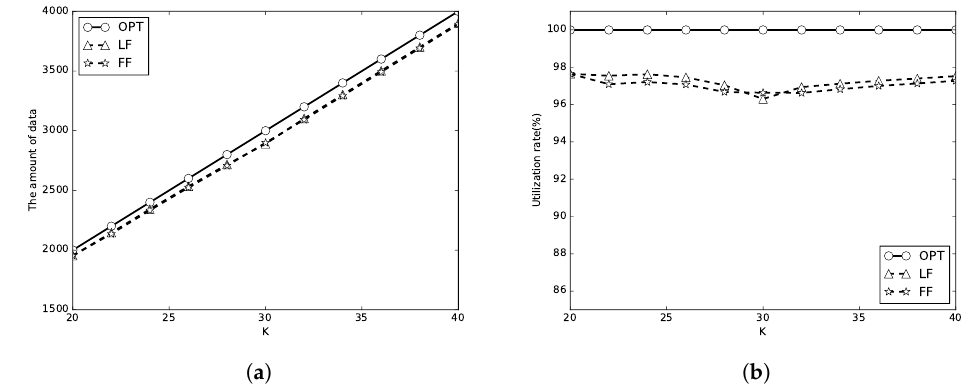
Figure 6. C = 2 E . ( a ) the amount of data; ( b ) energy utilization rate.